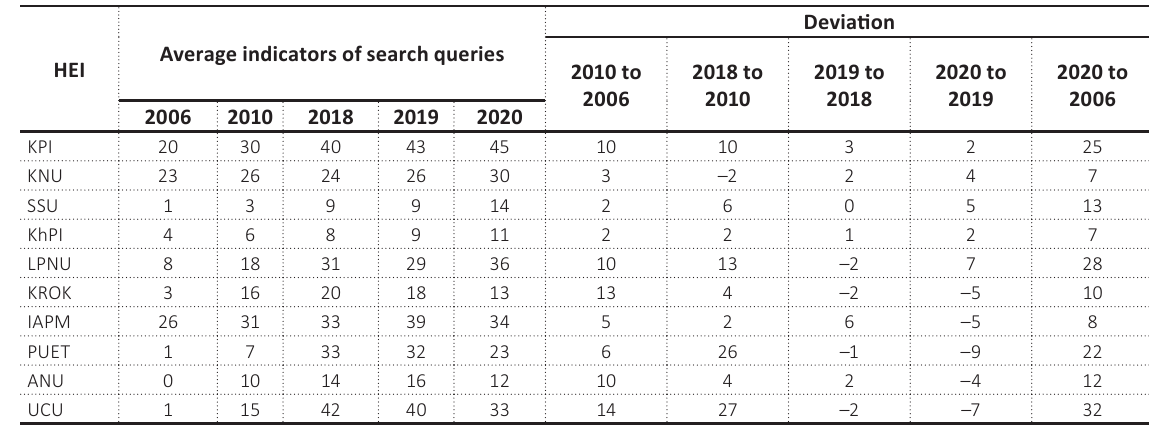
Table 2. Analysis of the relative number of queries under the official names of HEIS in Ukraine from 2006 to 2020 on Google platform,